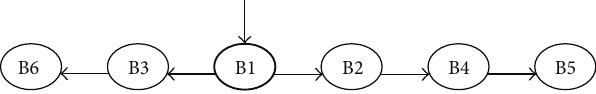
Figure 2: Schematic diagram for the filling sequence of